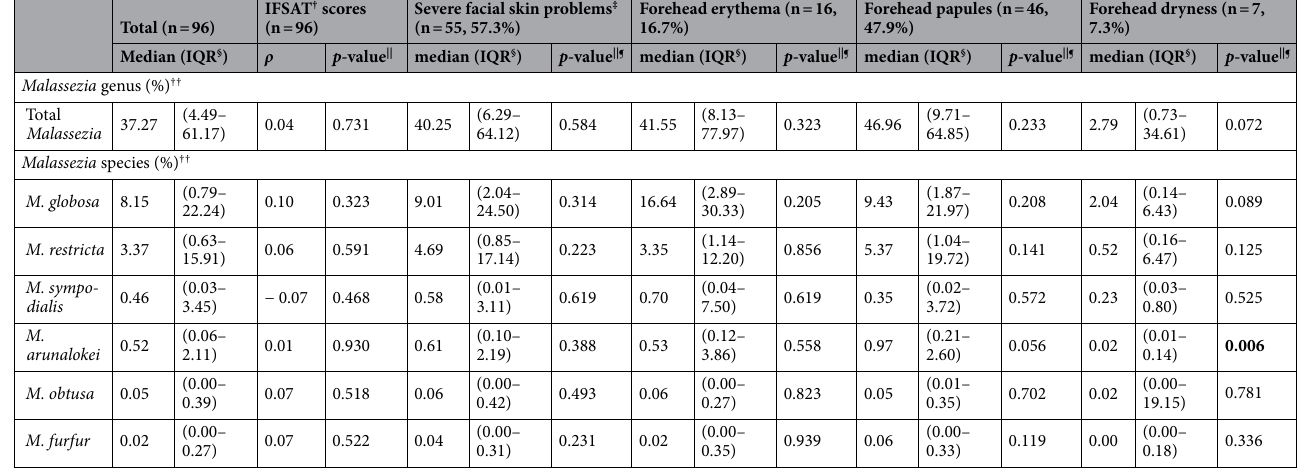
Table 4. Relationship of Malassezia with IFSAT scores, severe facial skin problems, forehead erythema, forehead papules, and forehead dryness (n = 96). Significant values are in bold. † Infant facial skin visual assessment tool (score 0–53), ‡ ≥ 8 points in case of infant facial skin visual assessment tool, § Interquartile total fungal populations was calculated. IFSAT infant facial skin visual assessment tool, IQR interquartile range.